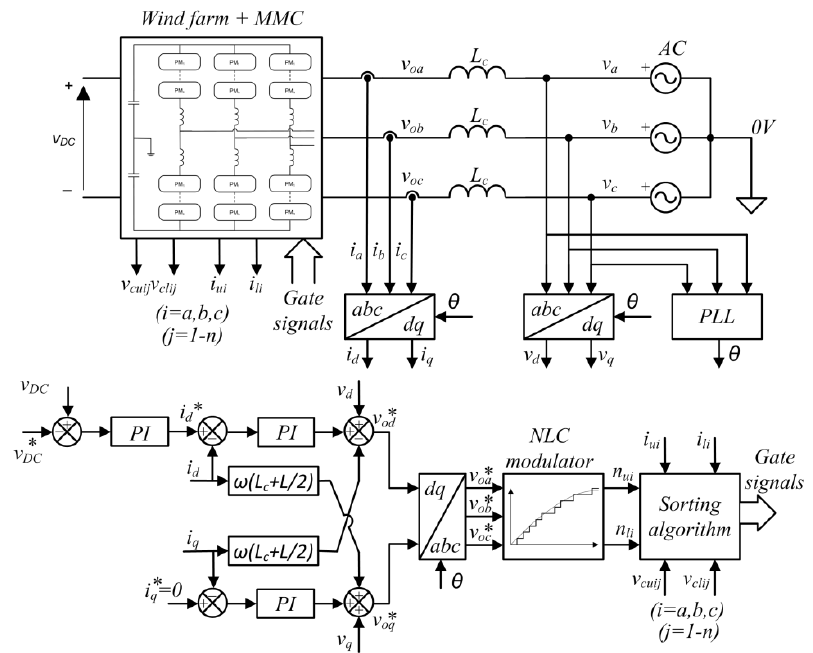
Figure 4. Control scheme of the new topology that integrates the wind generators into the structure of an MMC and uses an NLC modulator.